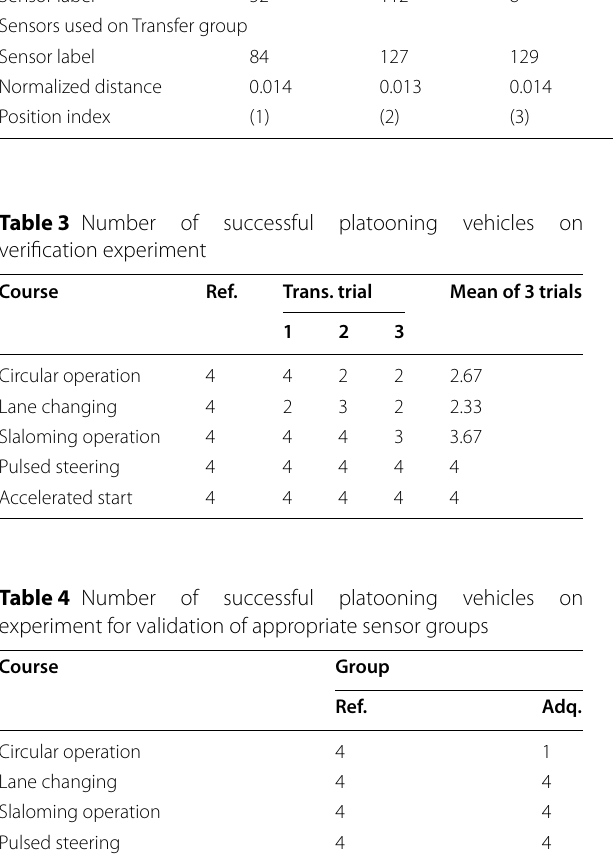
Table 2 Sensors used on verification experiment Sensors used on Reference group Sensors used on Transfer group